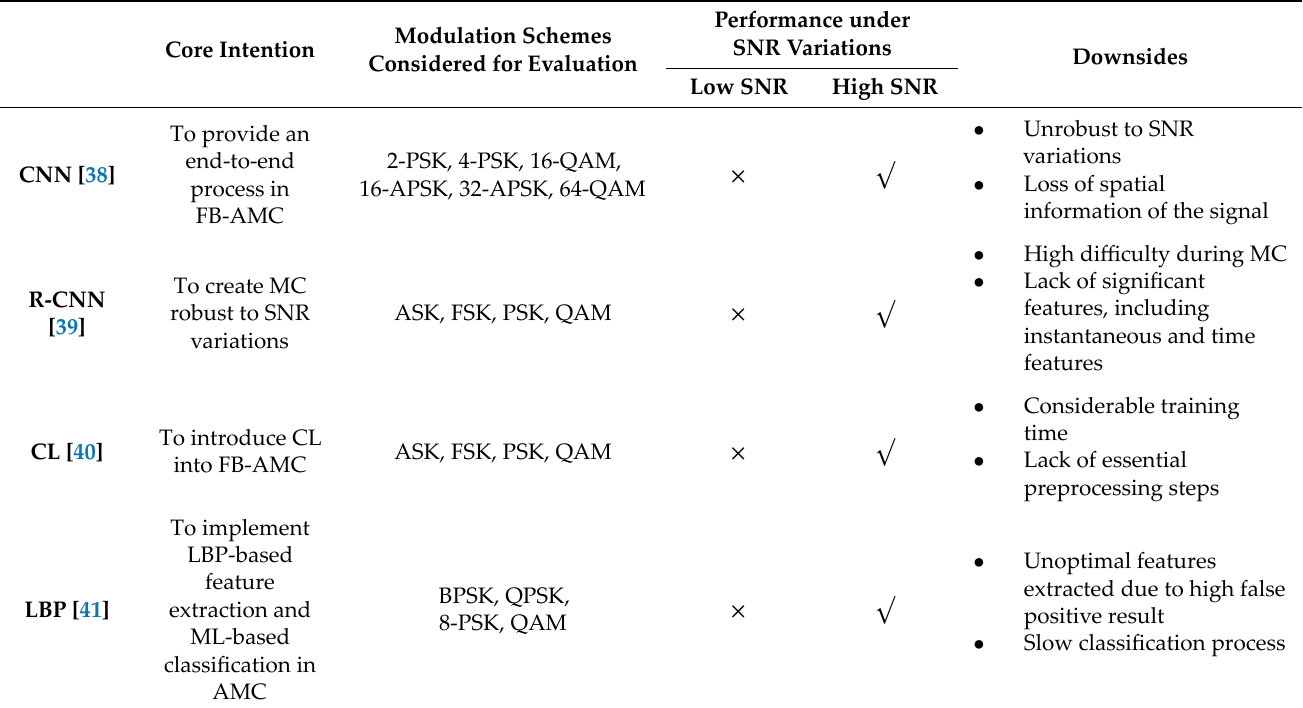
Table 6. Comparison of extraction methods.